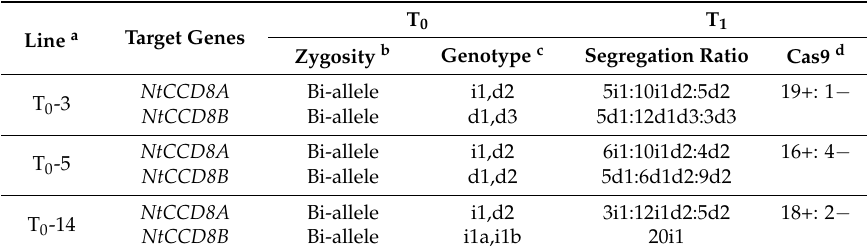
Table 2. Segregation patterns of CRISPR/Cas9-induced mutations in the NtCCD8 genes during the T 0 to T 1 generations.